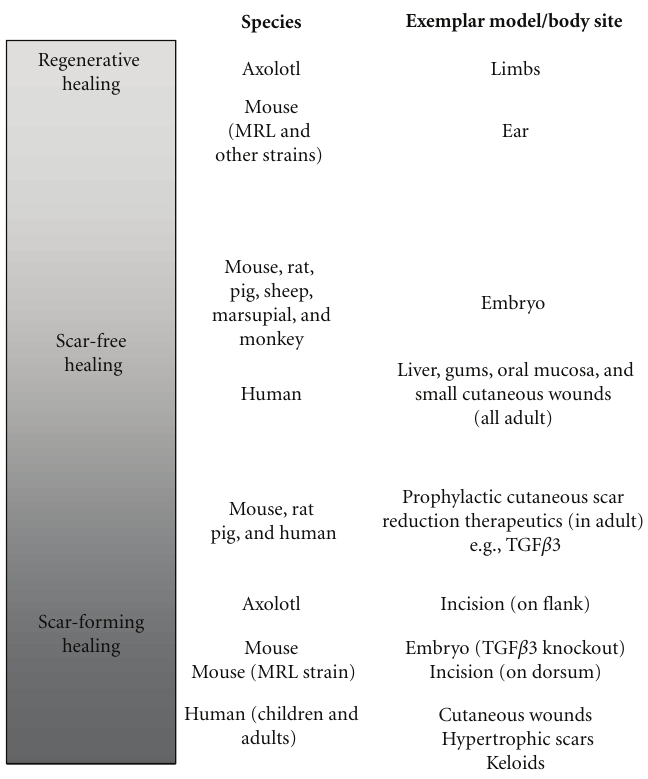
Figure 2: Scar-free to Scar-forming healing in vertebrates represents a continuous spectrum of